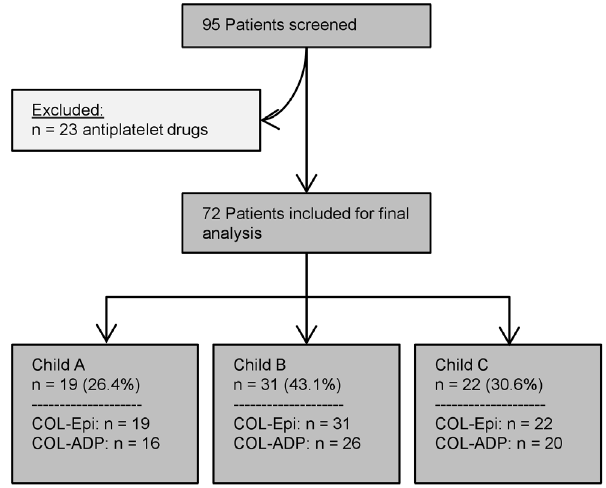
Figure 1. Selection of the study population. The enrolment details of the study population are shown, including the number of patients excluded because of the use of antiplatelet drugs or because there was no information on use of these drugs. For all subgroups, the number of available test results for PFA-100 with Col-Epi and Col-ADP is given.